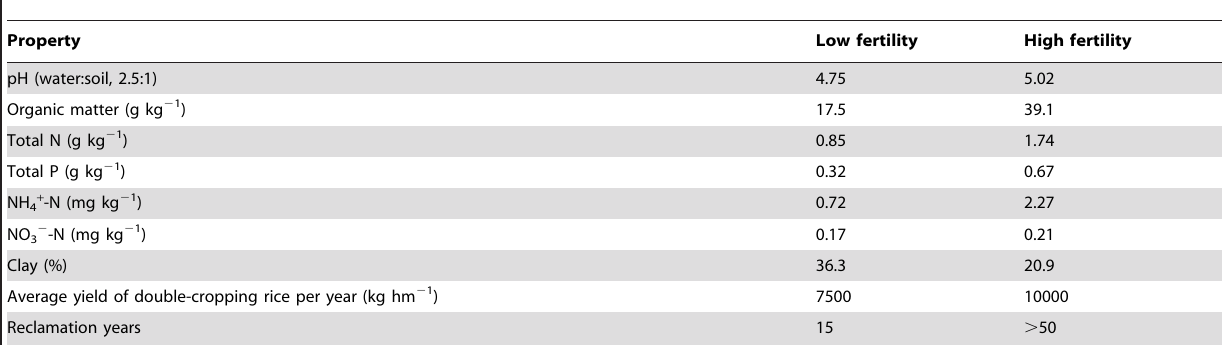
Table 1. Properties of the paddy soils used in the experiment.